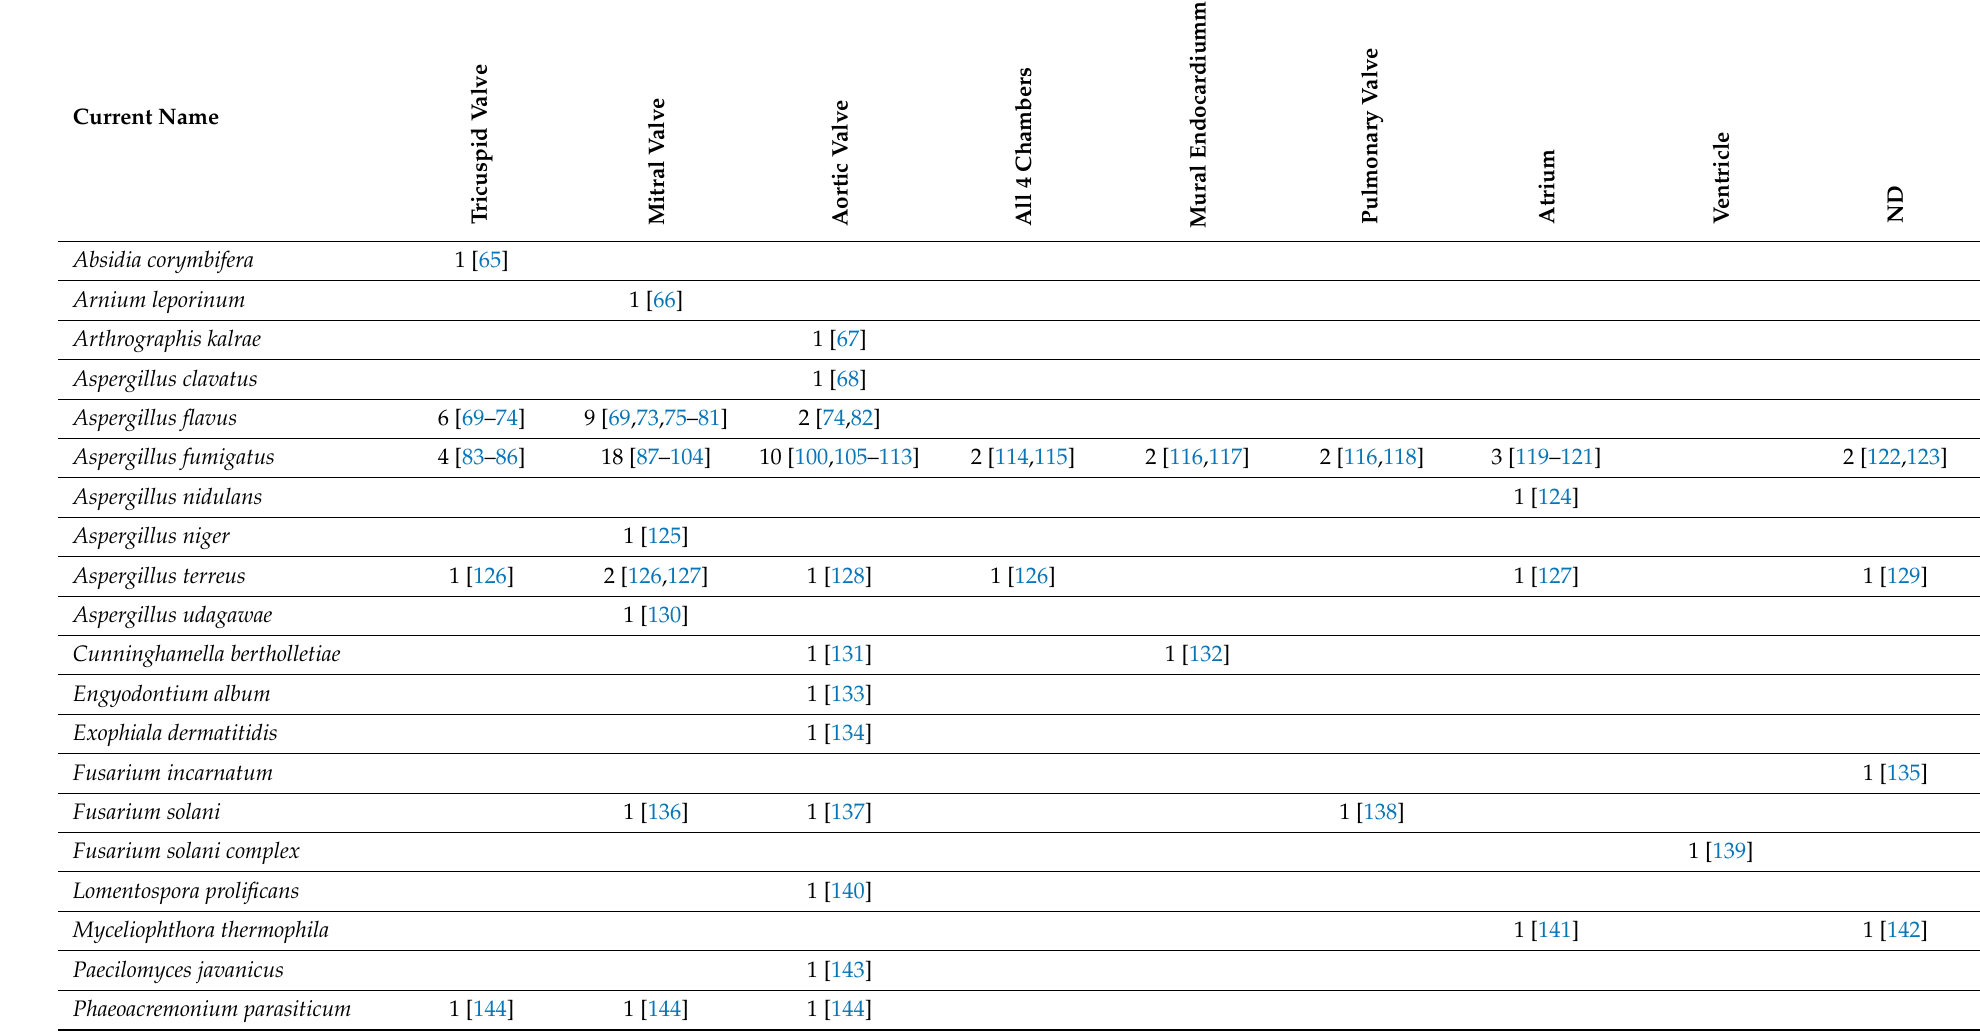
Table 3. Details of cardiac sites affected by native valve endocarditis and associated